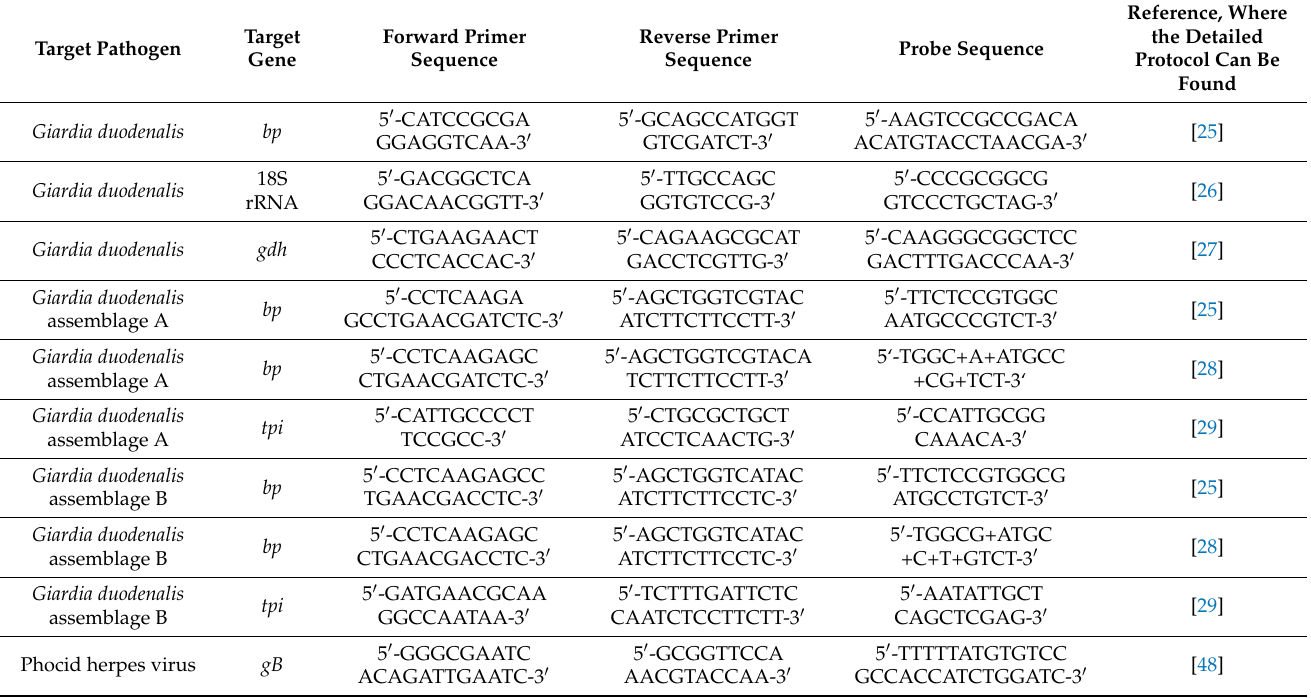
Table A1. Oligonucleotides applied for the compared real-time PCR